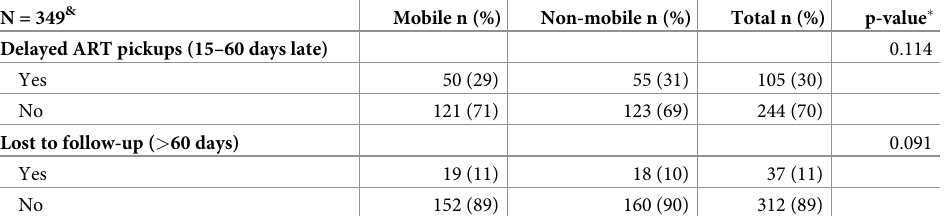
Table 4. Comparison of antiretroviral therapy (ART) spacing pick-ups between mobile and non-mobile HIV- infected adults enrolled in HIV care and treatment at Manhic¸a District Hospital. N = 349